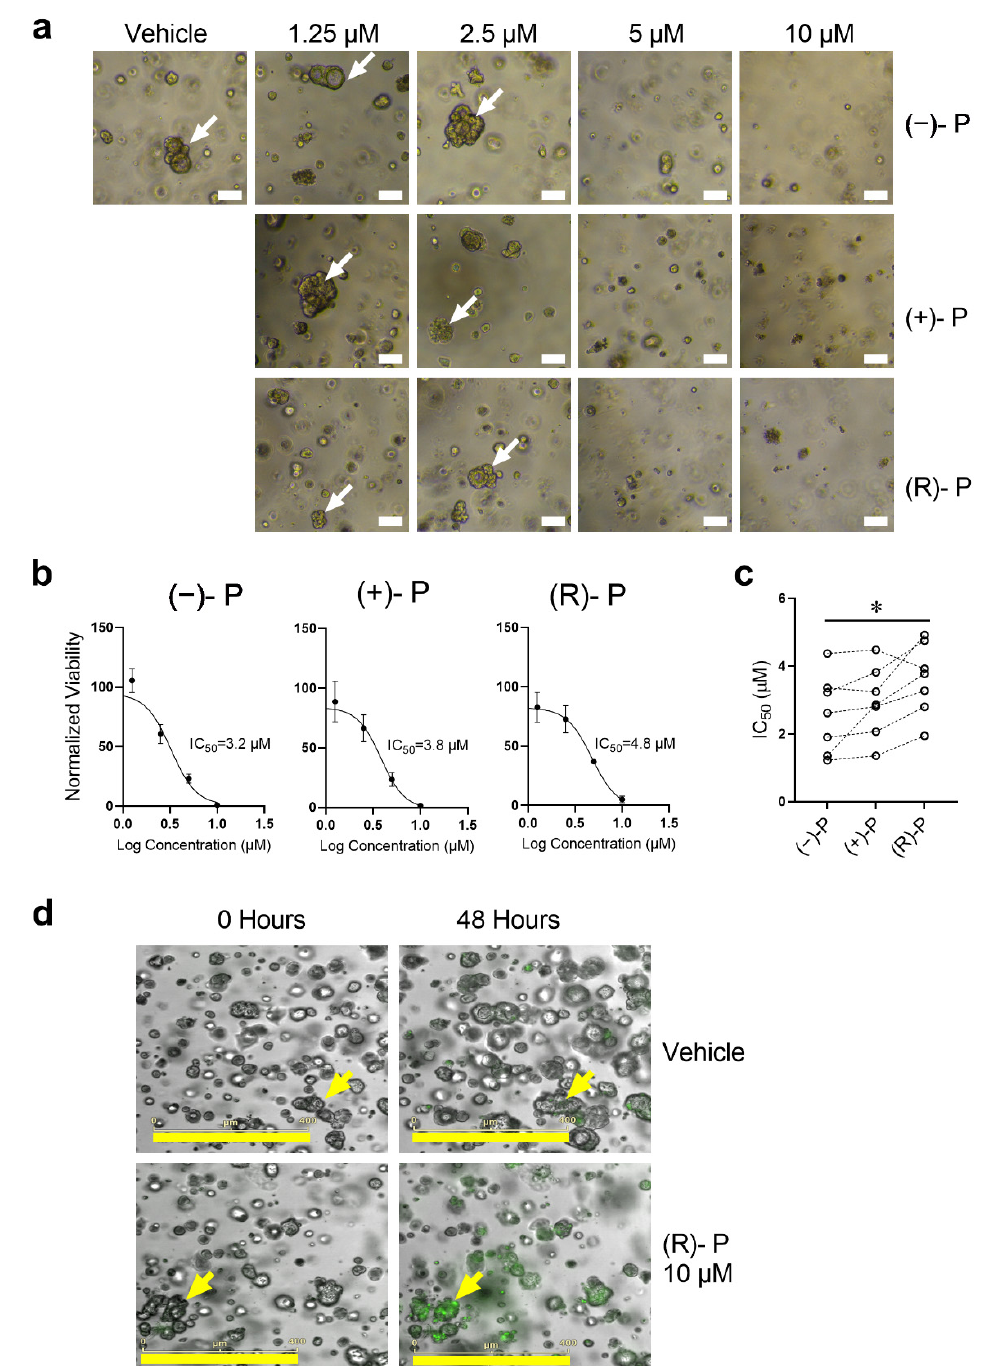
Figure 5. Disruption of CRC organoid structure following treatment with ( − )-P, (+)-P or (R)-P. CRC organoids were grown for 48 h followed by treatment with ( − )-P, (+)-P and (R)-P for 144 h. Images were taken before the addition of AlamarBlue dye. ( a ) Representative images of patient-derived liver metastatic CRC organoids (TQEH196) treated with ( − )-P, (+)-P and (R)-P. White bars represent 100 µm. White arrows indicate viable organoids. ( b ) Growth curve and calculated IC 50 values for ( − )-P, (+)-P and (R)-P of TQEH196. Individual points represent mean ± SD from four technical rep- licates. ( c ) IC 50 values for seven individual CRC patients. Dashed line denotes organoid IC 50 re- sponses from the same patient. * p ≤ 0.05, Friedman repeated measure ANOVA. ( d ) Representative images showing caspase 3/7 activation (green) denoting apoptosis by 10 µM of (R)-P in a patient- derived organoid 48 h post treatment. Yellow bars represent 400 µm; yellow arrows represent or- ganoids tracked overtime.